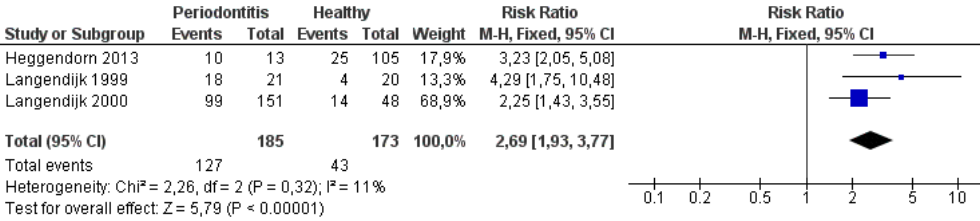
Figure 3. Meta-analysis of occurrence of sulfate-reducing bacteria (SRB) in a group of healthy people and patients with periodontitis. and patients with